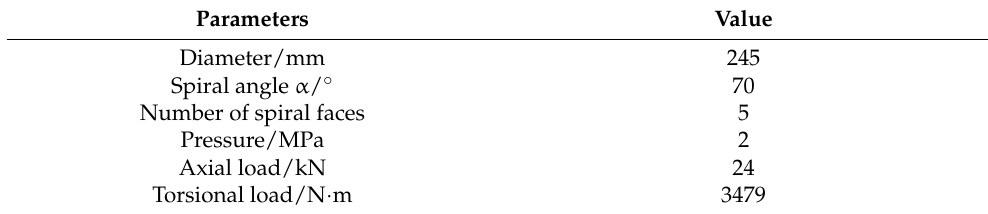
Figure 18. Schematic diagram of impact spiral surface. Table 5. Key parameters of the composite impactor.